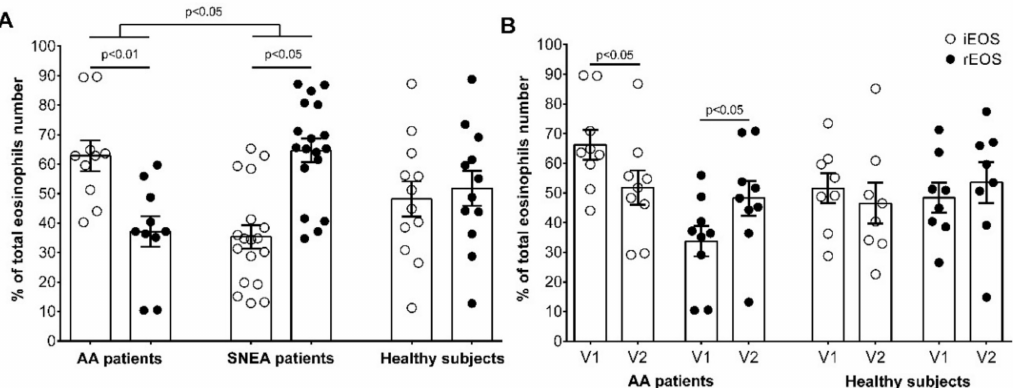
Figure 4. Blood rEOS and iEOS. ( A ) part of rEOS and iEOS in investigated individuals’ peripheral blood. ( B ) part of rEOS and iEOS in investigated individuals’ peripheral blood after bronchial allergen